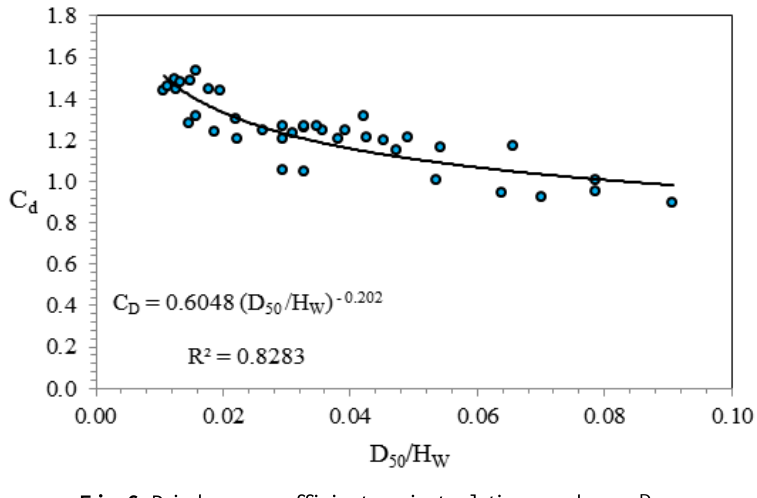
Fig. 6. Discharge coefficient against relative roughness